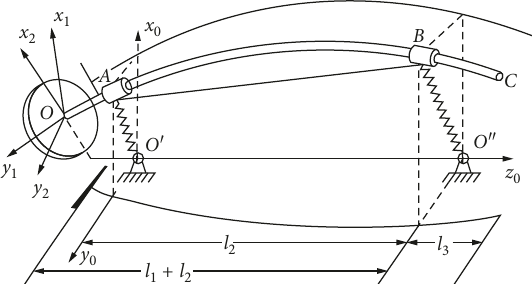
Figure 2: Rotor model of the flexible shaft and the elastic